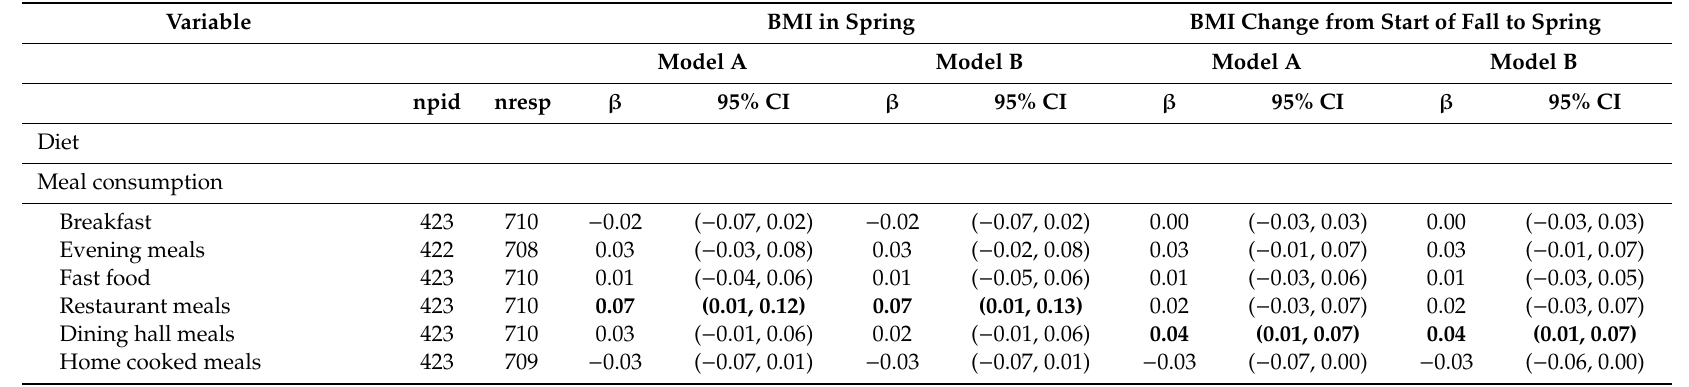
Table 4. Results of the longitudinal linear mixed e ff ect models examining if students’ survey responses on weight-related behavioral factors were associated with their BMI, or BMI